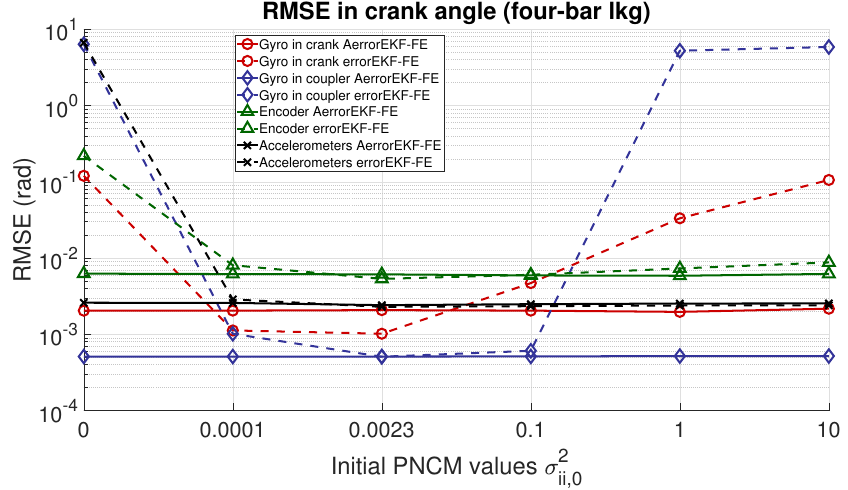
Figure 6. RMSE in the crank angle (position) provided by the observers for the four-bar